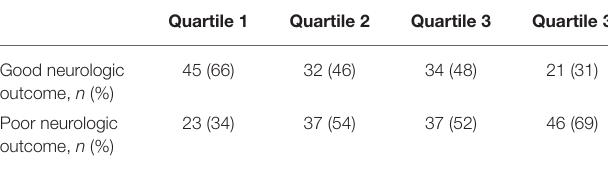
TABLE 3 | Multivariable analysis of the primary endpoint.